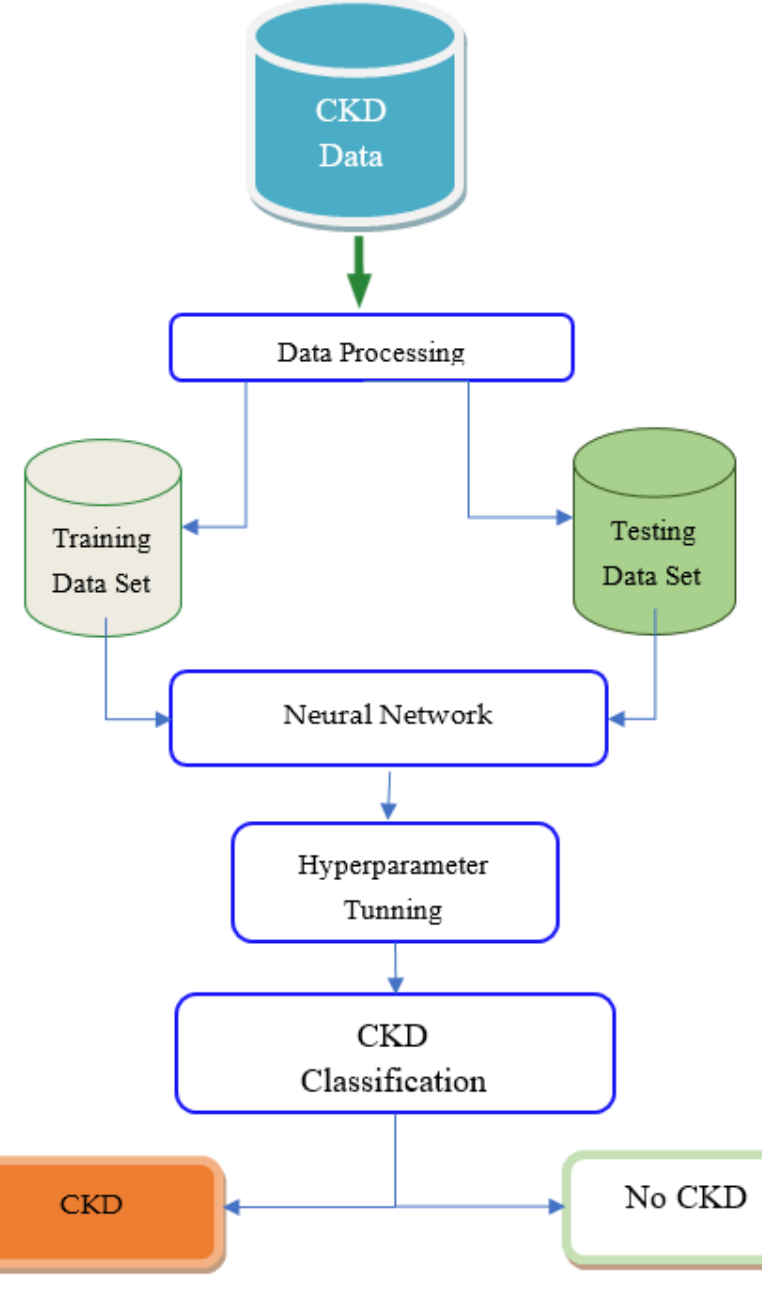
Figure 5. A framework of the proposed model.